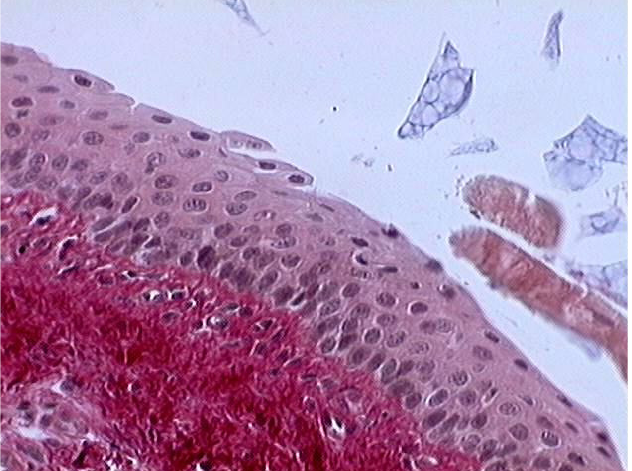
FIGURE 4 – Sample slide stained by picrosirius red demonstrating amorphous substance, respiratory epithelium and submucosa